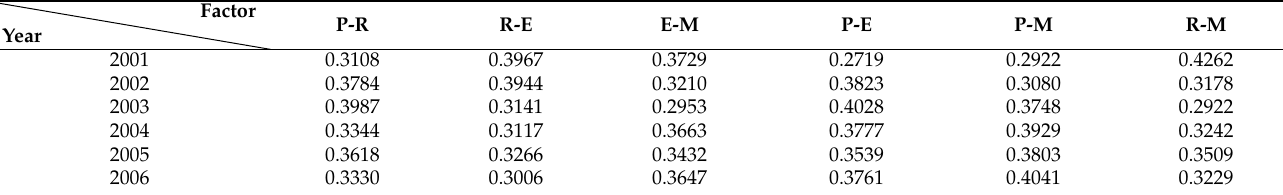
Table 4. The coupling degree B j of two risk